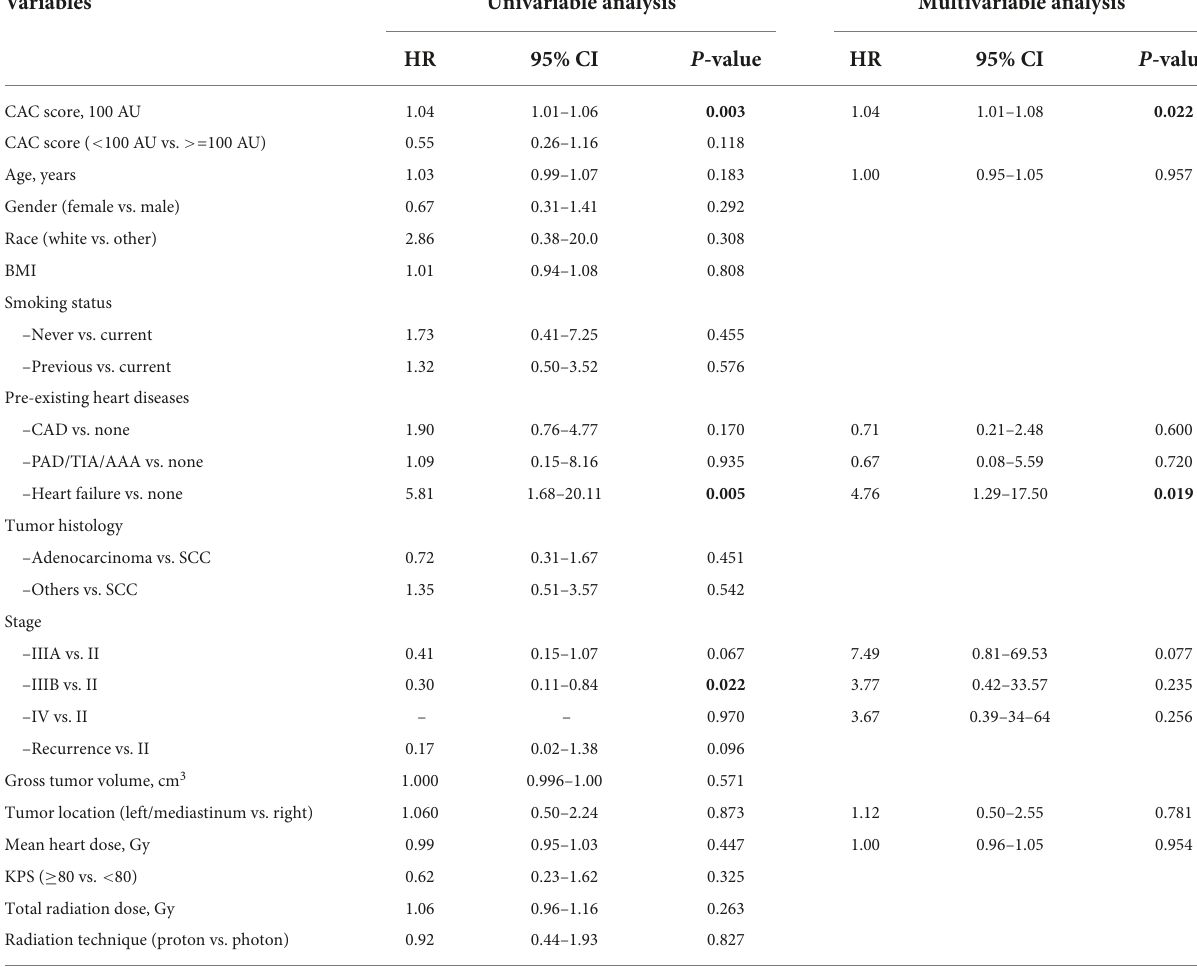
TABLE 2 Association of demographic and baseline clinical characteristics with development of grade ≥ 2 CVAEs based on univariable and multivariable Cox regression analysis.